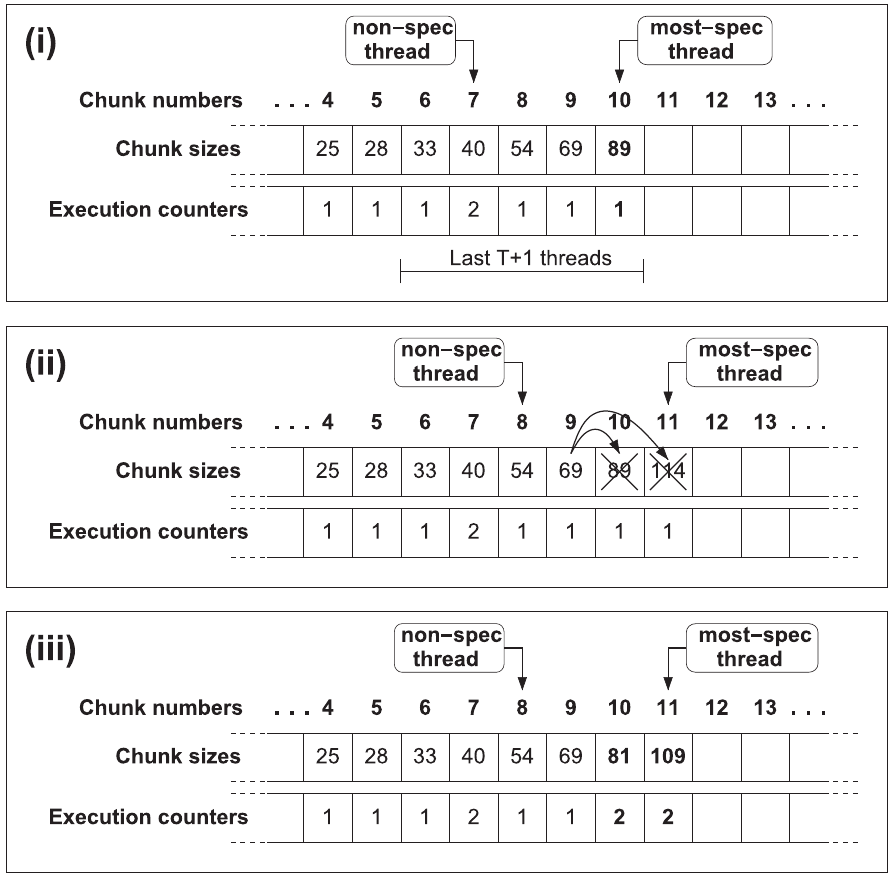
Fig 9. Adaptive Moody Scheduling. (i) Size of chunk #10 is calculated with the Moody Scheduling function. (ii) Chunk #9 issues a squash operation. (iii) All squashed threads recalculate in program order the size of the chunk to be executed, using the updated values of the execution